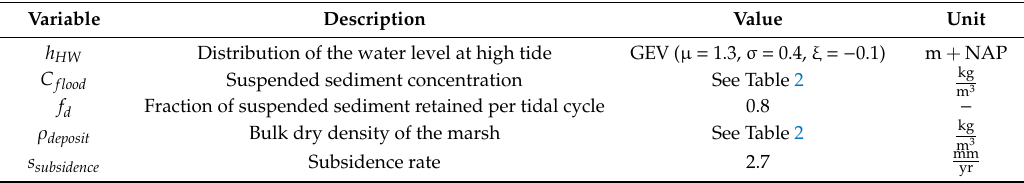
Table A1. Marsh accretion